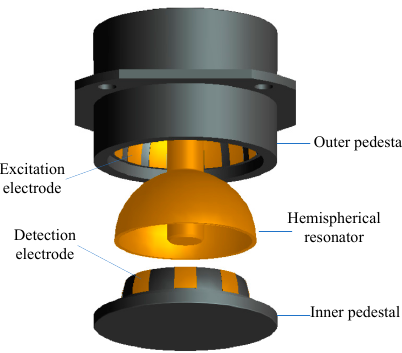
Figure 1. Structure of a hemispherical resonance gyroscope (HRG).